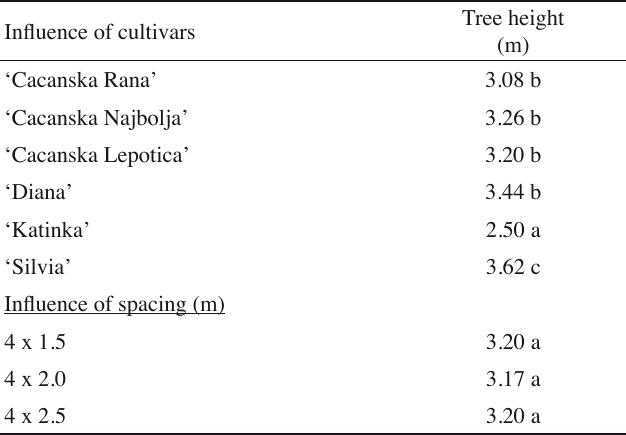
Table 2 - Influence of cultivars and spacing on tree growth expressed by tree height in the fourth year from planting (2008) Influence of cultivars